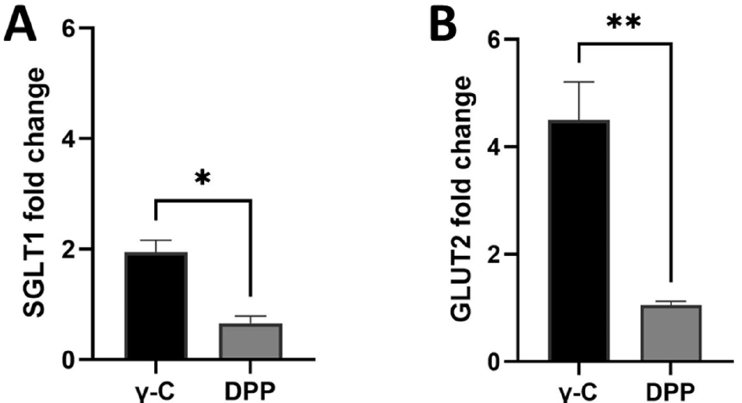
Figure 6. Effects of the 4-h incubation of undifferentiated Caco-2 cells with 1.00 mg/mL ( γ -C) and pepsin and pancreatin digested sample (DPP) on SGLT1 ( A ) and GLUT2 ( B ) gene expression. Data are expressed as mean ± standard deviation. * p ≤ 0.05, ** p ≤ 0.01.